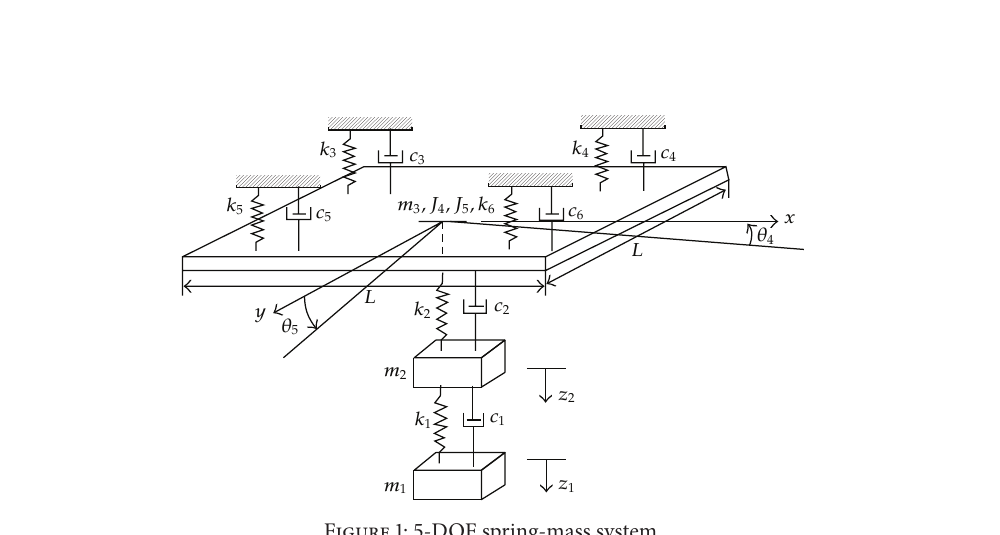
Figure 1: 5-DOF spring-mass